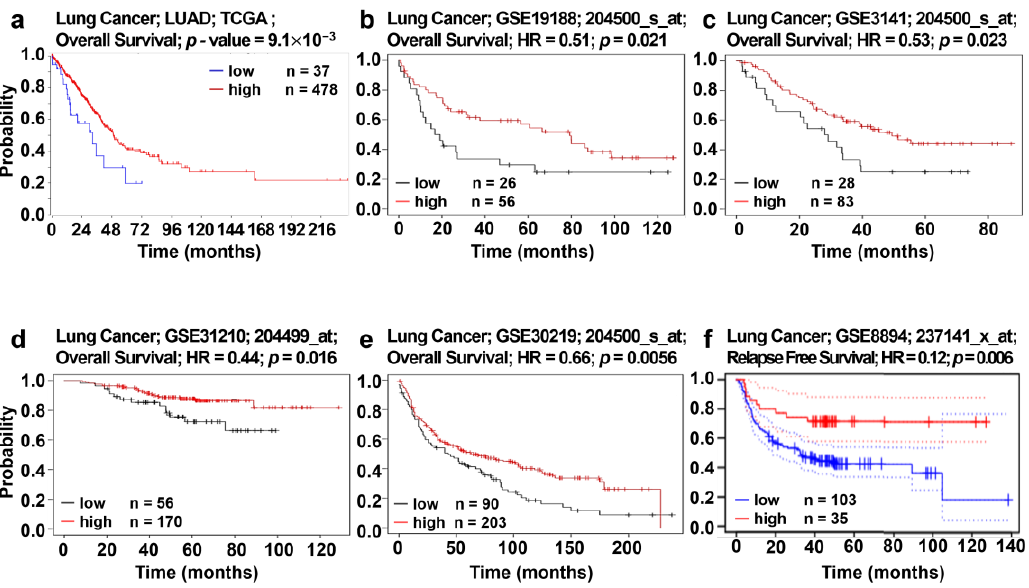
Figure 5. Kaplan-Meier survival curves for lung cancer patients according to ATP/GTP binding protein 1 ( AGTPBP1 ) expression in non-small cell lung carcinoma (NSCLC). ( a ) Survival curve comparing high and low AGTPBP1 expression groups of in LUAD datasets of TCGA (LUAD-TCGA) from R2 database. ( b – e ) Overall survival curves of NSCLC in four different lung cancer datasets, including GSE19188 ( n = 82), GSE3141 ( n = 111), GSE31210 ( n = 226), and GSE30219 ( n = 293) in Kaplan-Meier plotter. ( f ) Relapse free survival pattern of the NSCLC cohort GSE8894 ( n = 138) in PrognoScan. Statistical significance was determined using p- value threshold < 0.05 in all